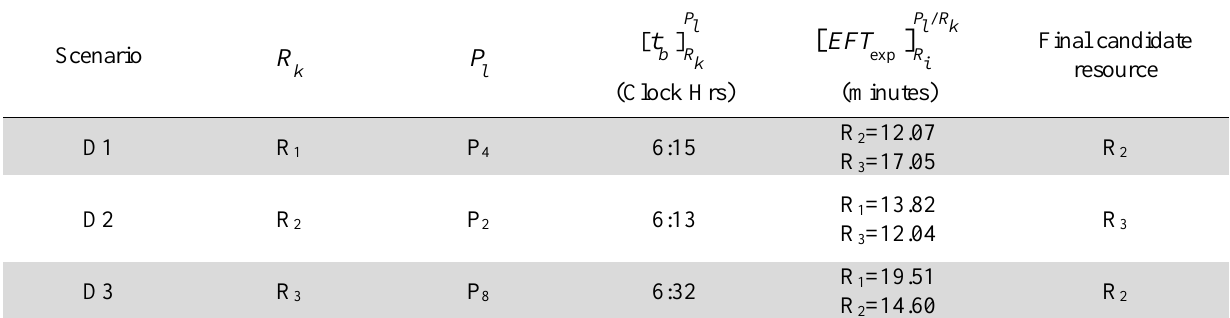
Details of resource break down scenario and procedural outcome of metamorphic algorithm